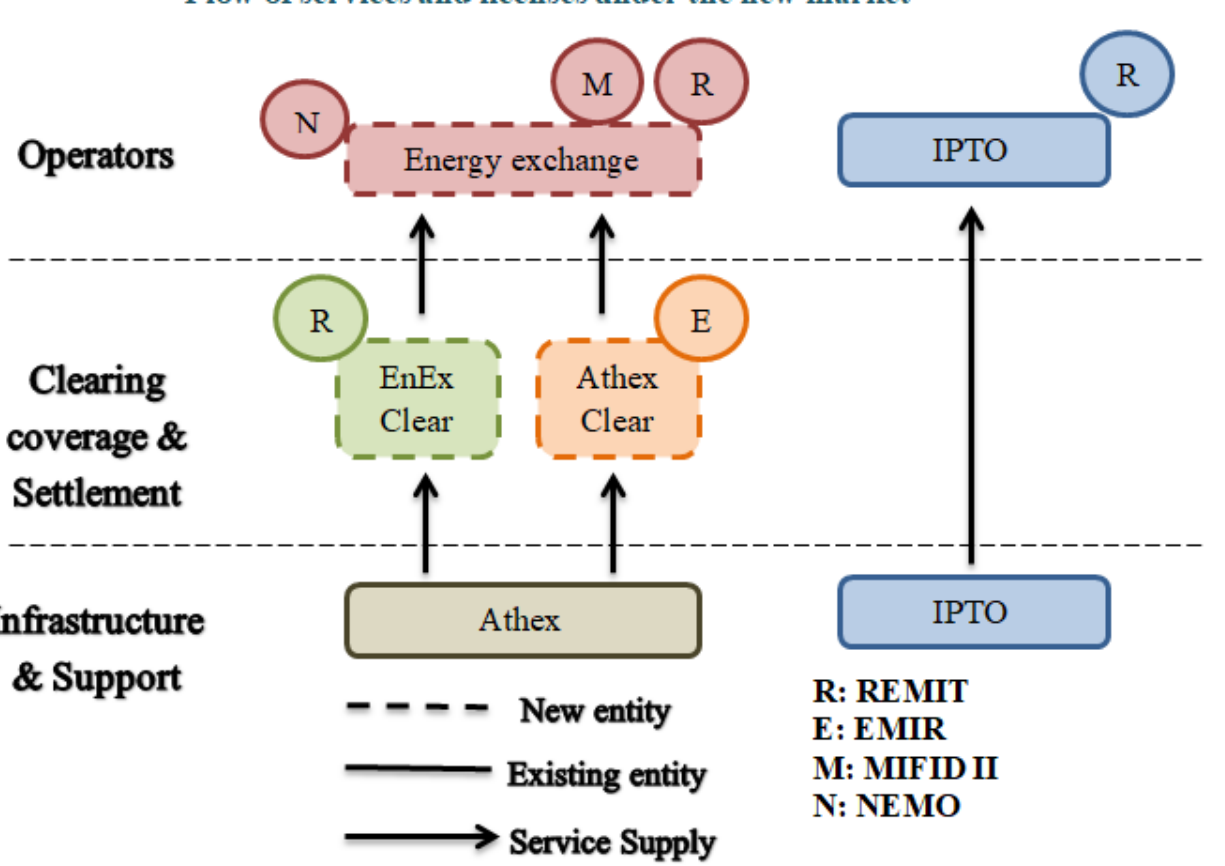
Figure 2. Services under the new market structure in Greece [14].